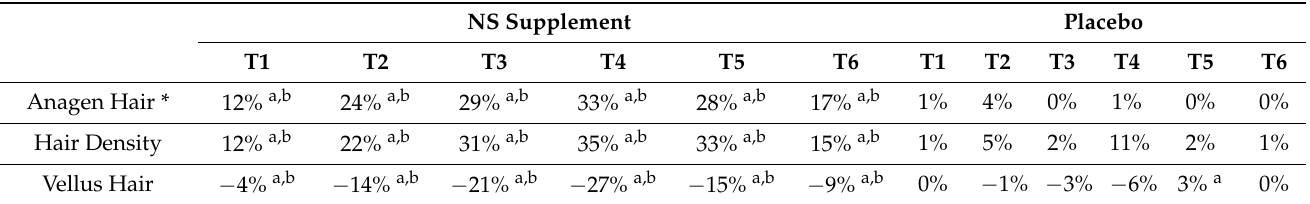
Table 2. % increase in the percentage of hair in the anagen phase, the density of hair in the anagen phase (n/cm 2 ), and vellus hair (miniaturized, smaller, and thinner